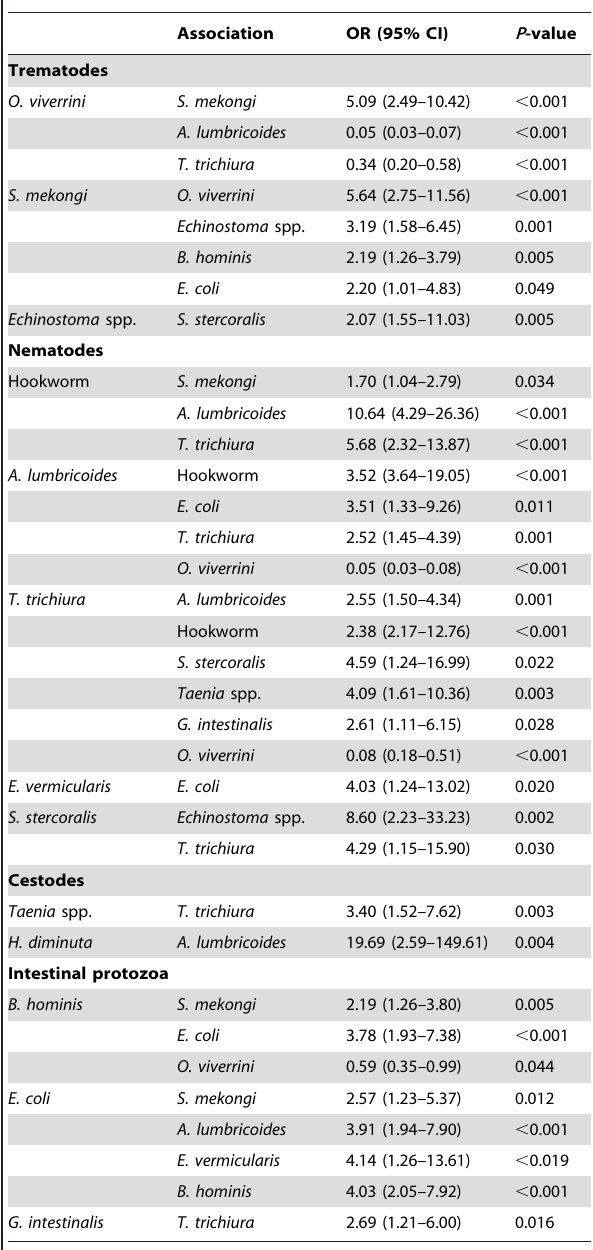
Table 3 summarizes significant associations between different intestinal parasites. An O. viverrini infection showed a significant positive association with S. mekongi (odds ratio (OR) =5.09, 95%